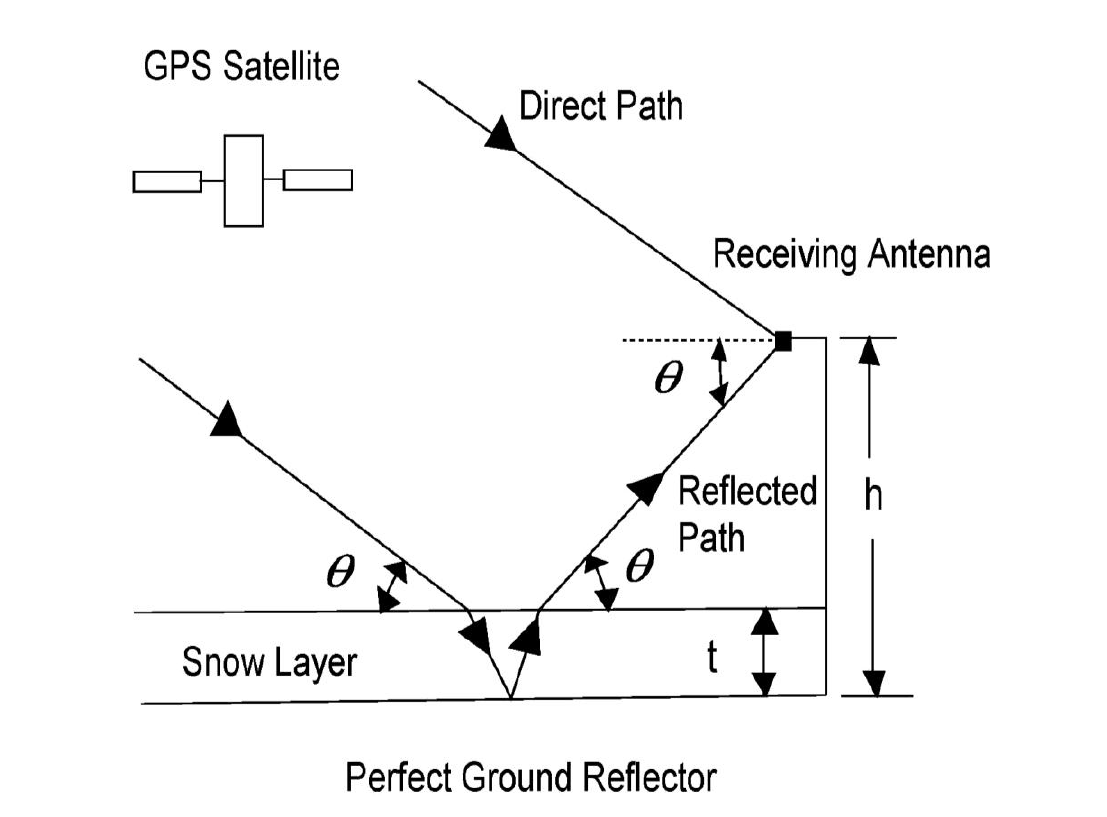
Figure 1. Geometry of the total GPS L1 signal at the receiving antenna with a height h above a perfect ground reflector. Snow layer has a thickness of t . The elevation angle is given by 